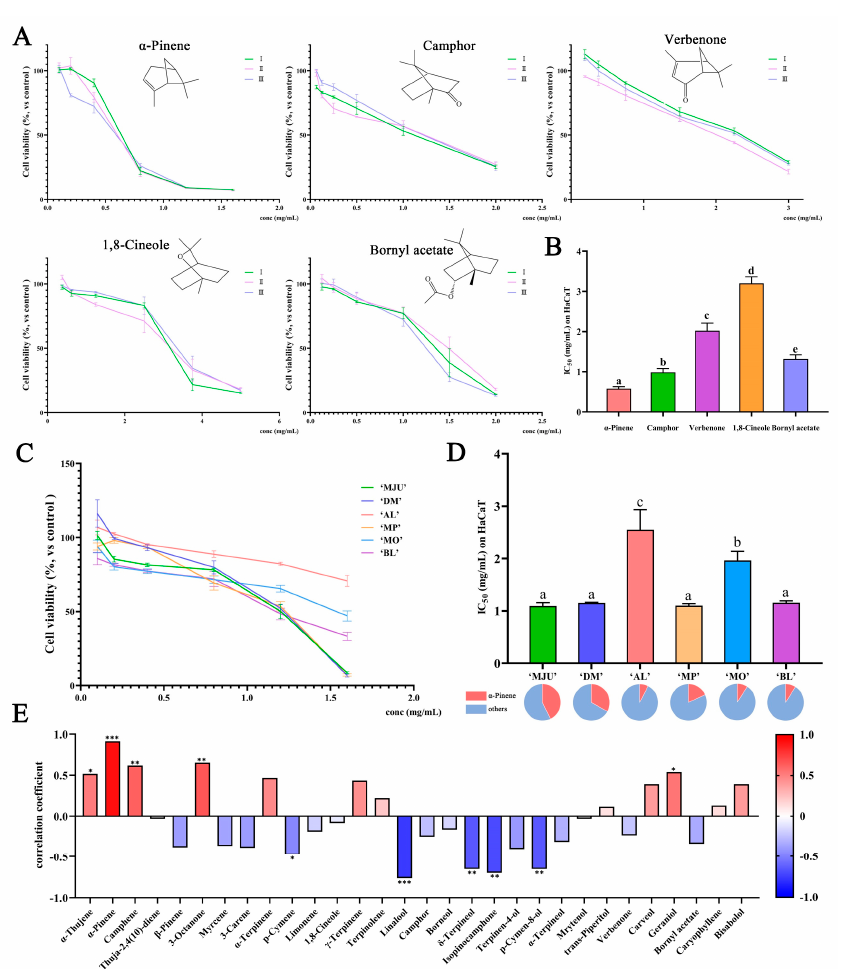
Figure 3. ( A ) The cytotoxicity of the 5 main compounds on HaCaT. ( B ) The IC 50 of the 5 main compounds on HaCaT. ( C ) The cytotoxicity of REOs on HaCaT. ( D ) The IC 50 of REOs on HaCaT. ( E ) The heatmap of Spearman correlation coefficient results between component and cytotoxicity. Data were expressed as means ± standard deviation (SD) (* 0.01 < p < 0.05, ** 0.001 < p < 0.01, *** p < 0.001). Means with different letters in the same column are significantly different ( p < 0.05).